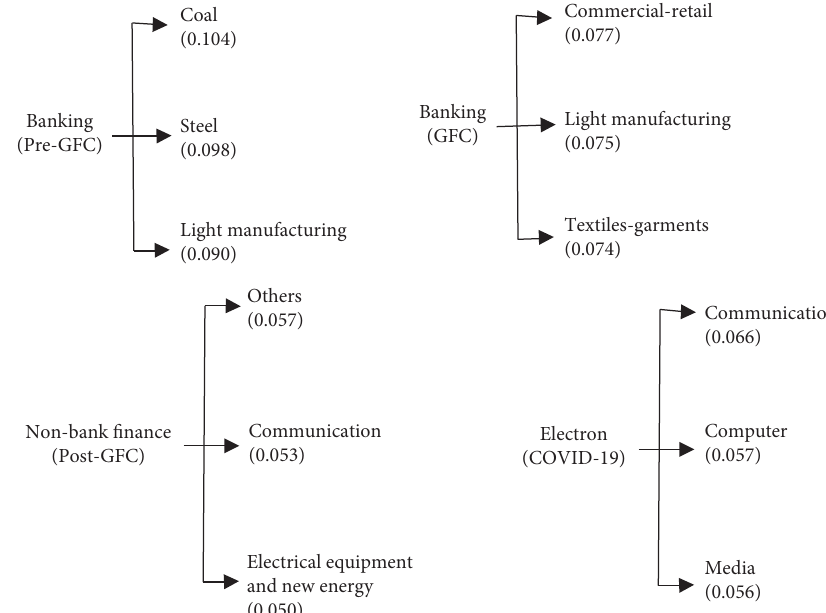
Figure 11: The three sectors that received the largest risk from the systemically most important sectors in four periods.